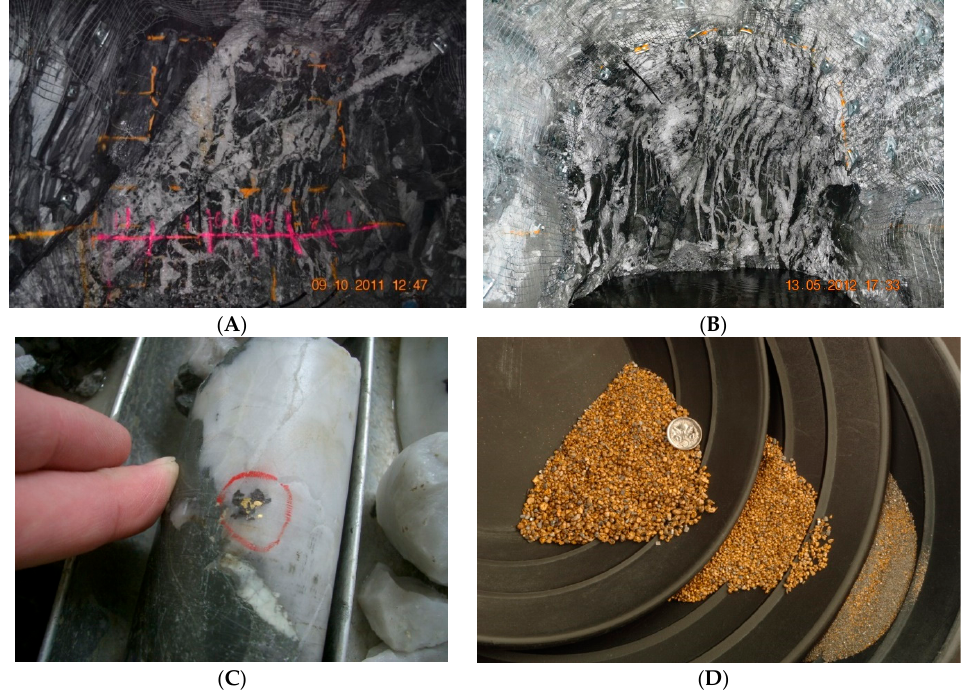
Figure 1. ( A ) West-dipping Sovereign Mako lode (width of face approx. 5 m); ( B ) Llanberris Mako Tiger lode (width of face approx. 5 m); ( C ) Gold particles in core; and ( D ) liberated gold from processing.